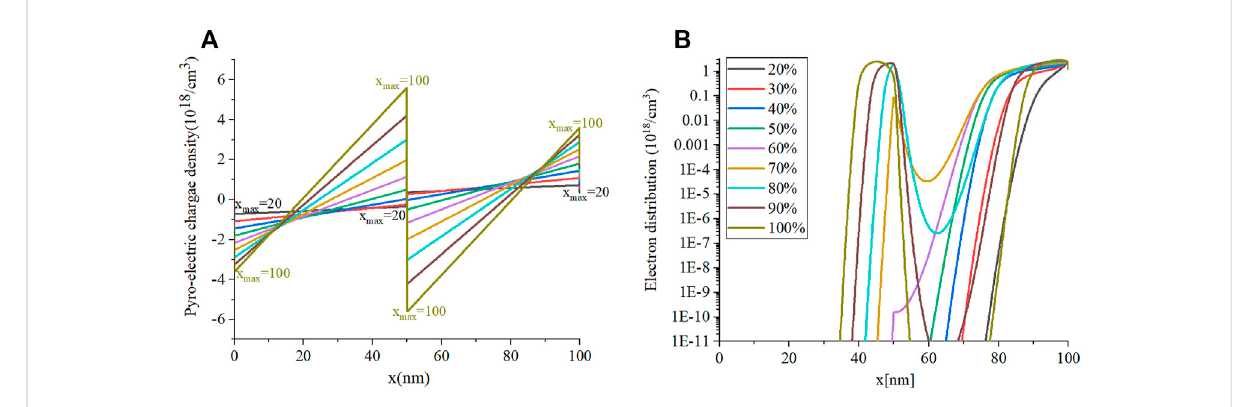
vanishingly small freecarriersof eithertype. However, now, we seefor the band diagram of the x max = 100% device in Figure 6B that there are additional barriers for the current to fl ow through the device. This results in increased V oc which we will see in the following paragraphs.